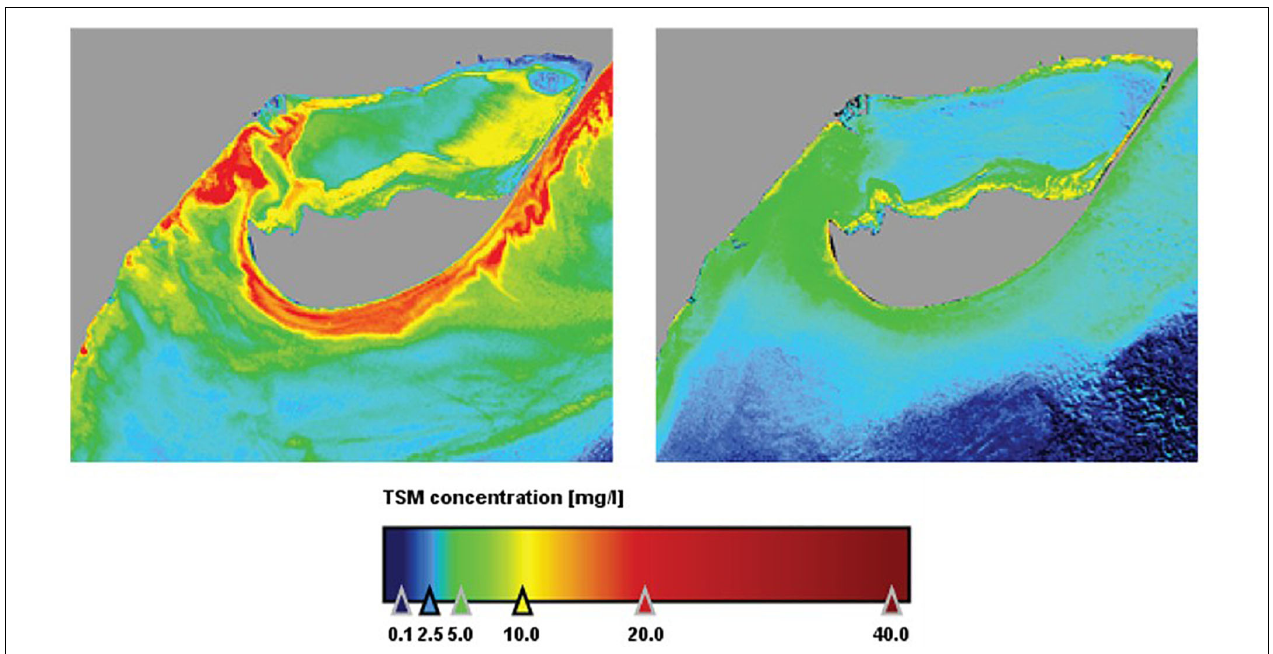
FIGURE 5 | Total Suspended Matter (TSM in mg/l) in the Ebro delta southern bay, derived from Sentinel-2 data for two different scenarios: NW winds ( left panel: 27th December, 2017) and calm conditions ( right panel: 15th February, 2018). The images depict the TSM originating from local resuspension and irrigation discharges – within the bay domain – plus the TSM contributed by the main river mouth (not shown) located above the figure